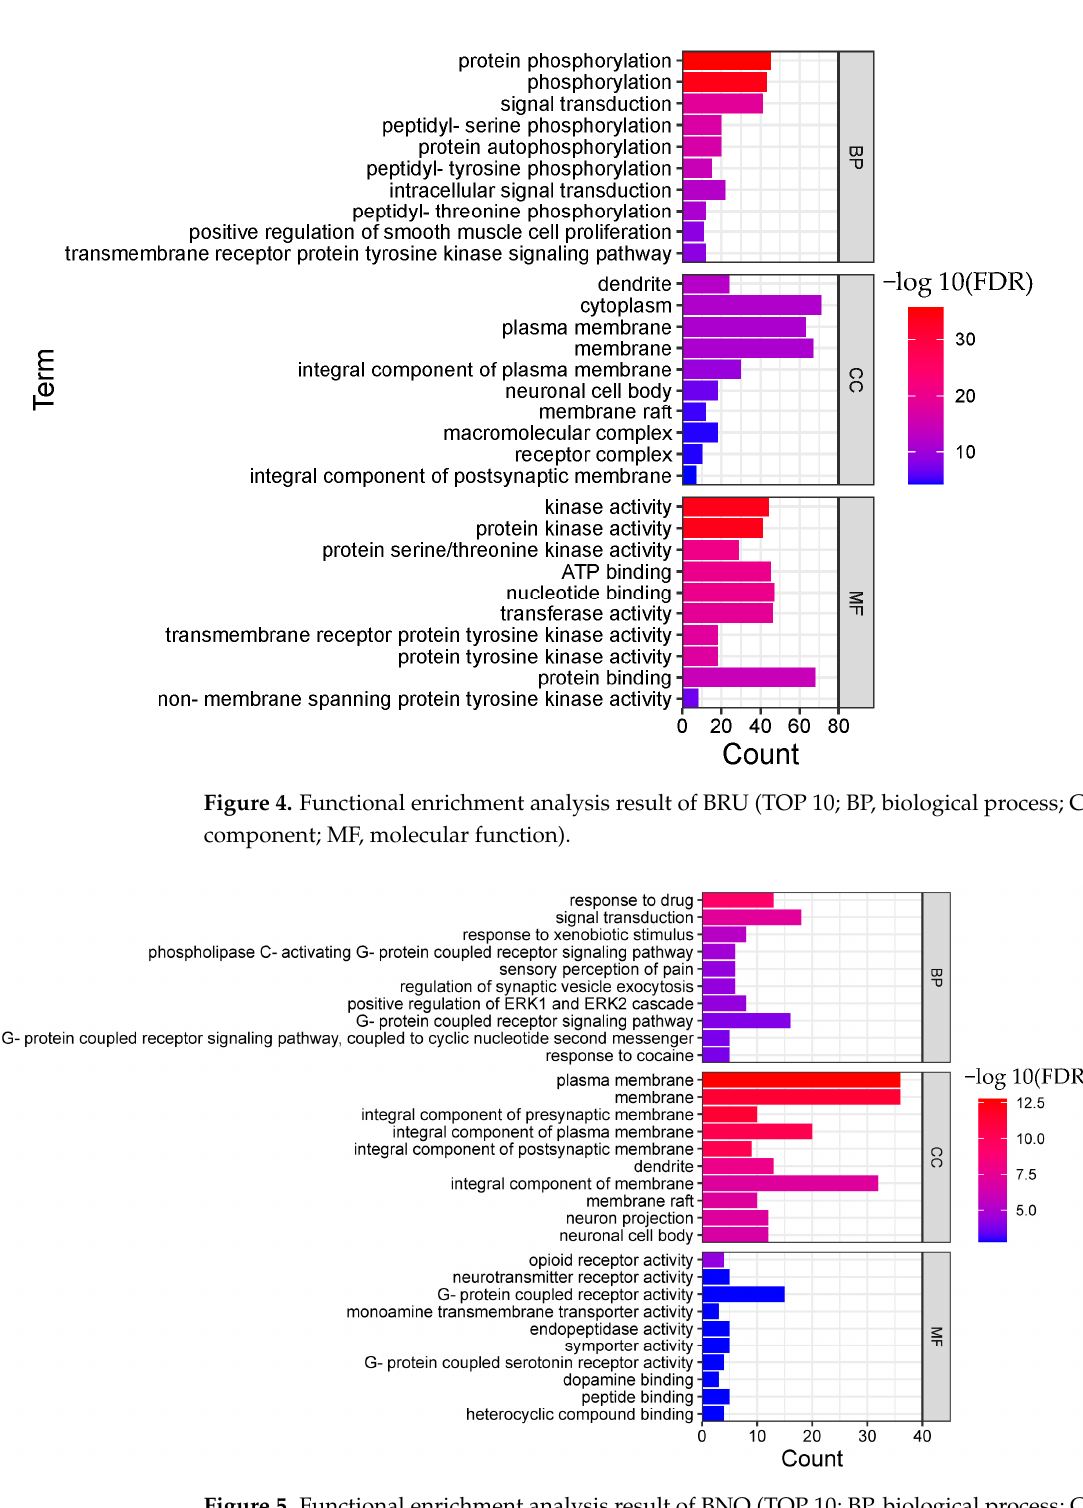
Figure 5. Functional enrichment analysis result of BNO (TOP 10; BP, biological process; CC, cellular component; MF, molecular function).